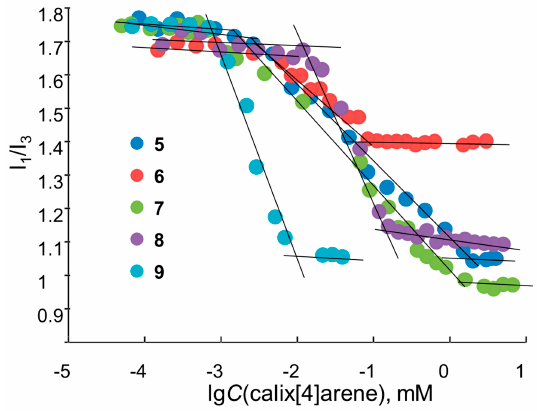
Figure 1. Fragment of the 1 H- 1 H NOESY NMR spectra of 5 (CDCl 3 ).